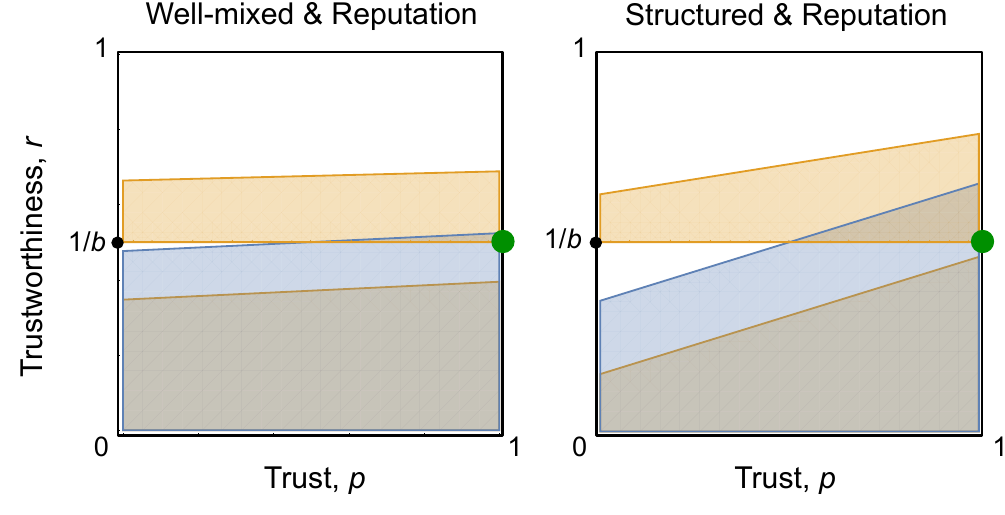
Figure 4. Reputation decreases the density of strategies with low trustworthiness ( r < 1 /b ) that are selected for and increases the density of strategies with high trustworthiness ( r > 1 /b ), both in a well-mixed and in a structured population. If there is sufficient knowledge of reputation then the winning strategy is one that is both trusting and trustworthy, (1 , 1 /b + (cid:15) ) . Light blue = strategies selected for in the absence of reputation; light orange = strategies selected for with reputation.